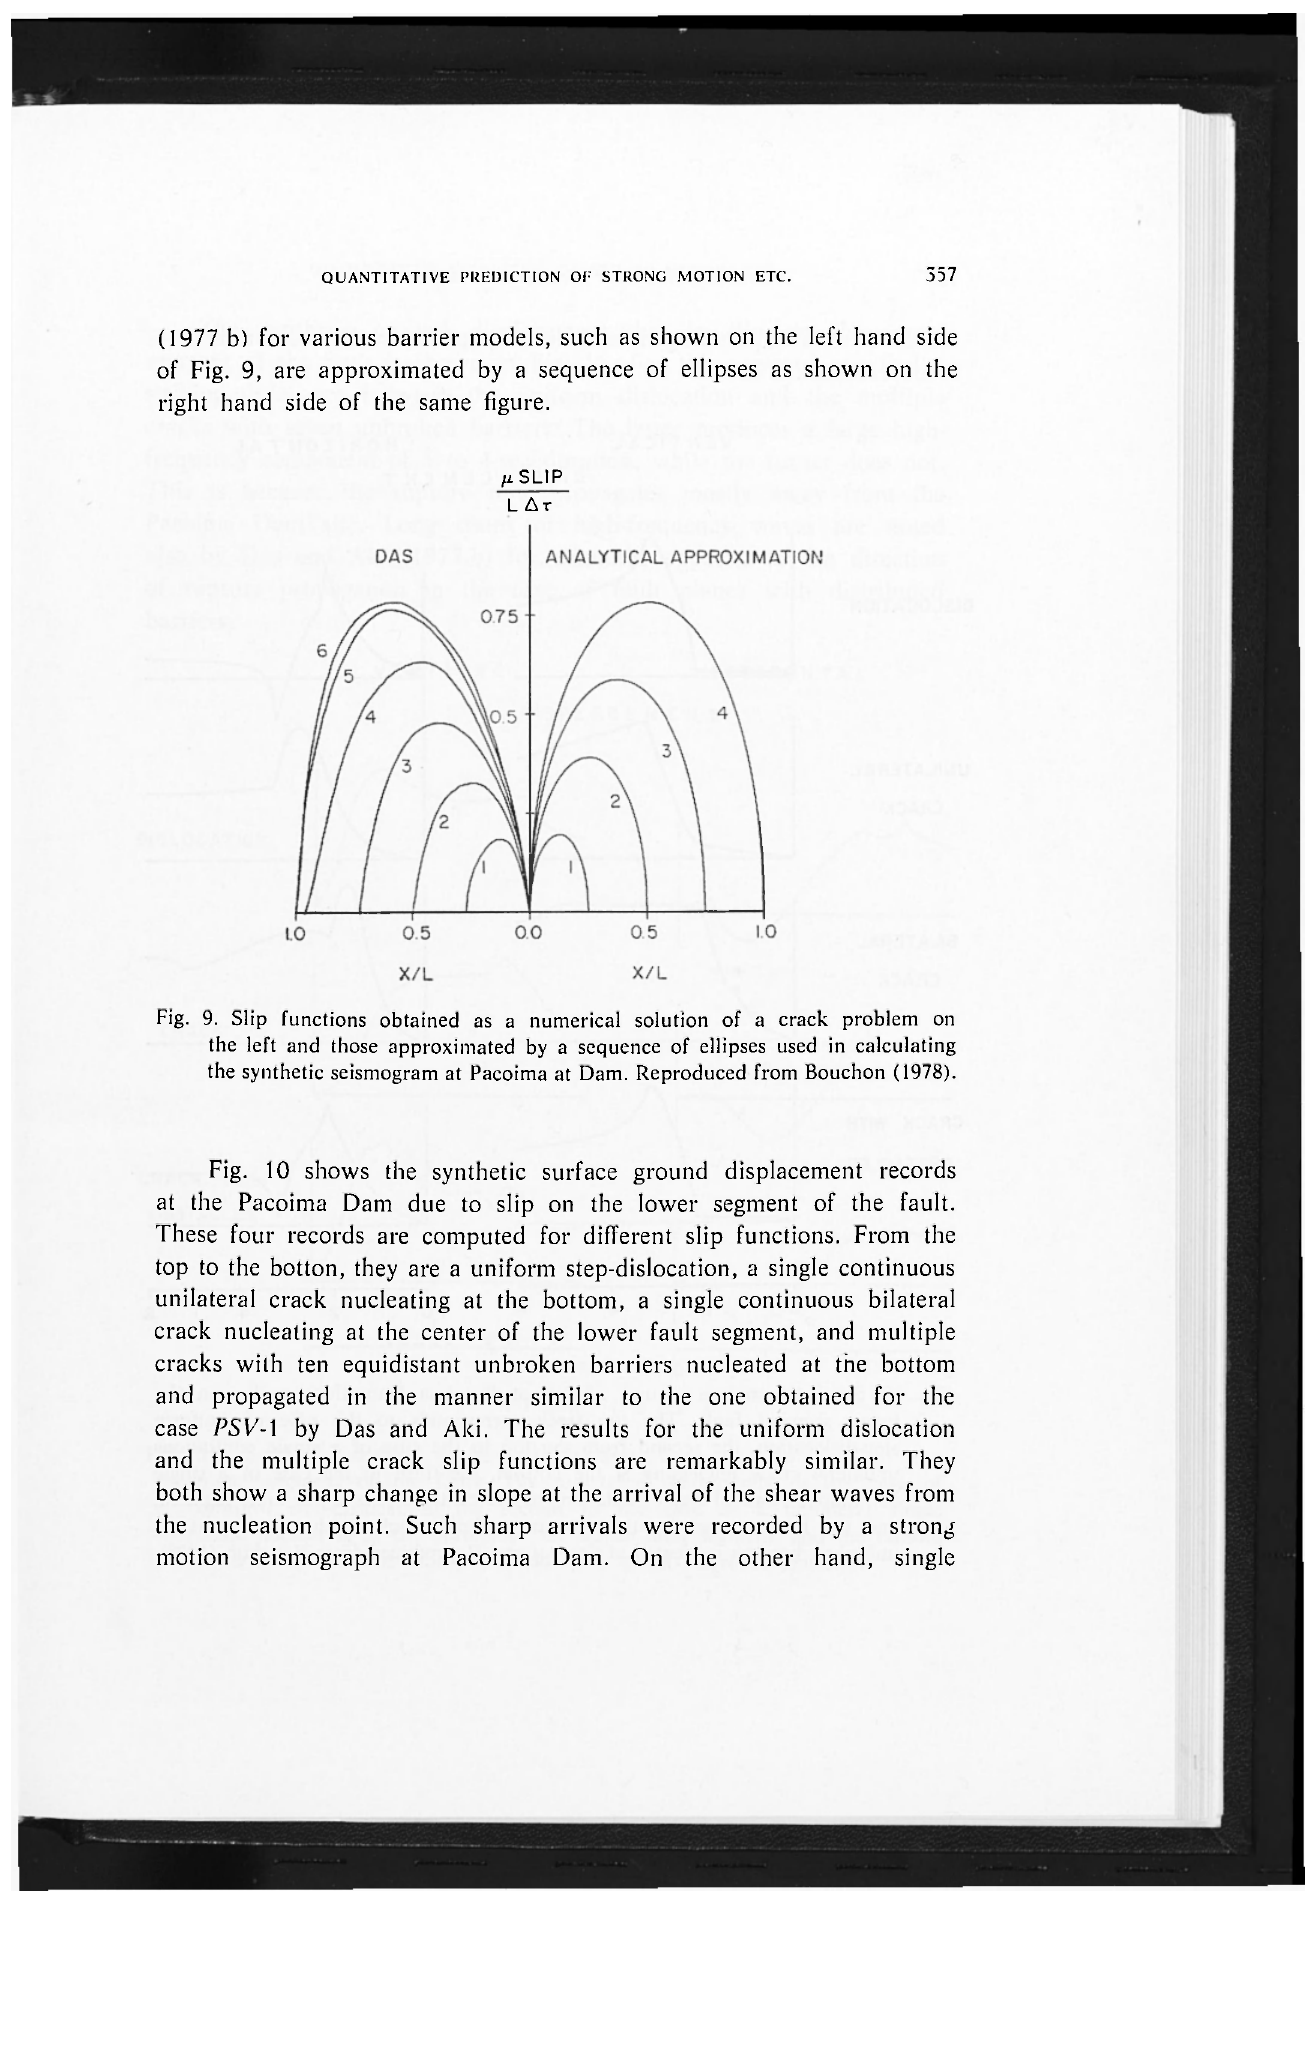
Fig. 10 shows the synthetic surface ground displacement records at the Pacoima Dam due to slip on the lower segment of the